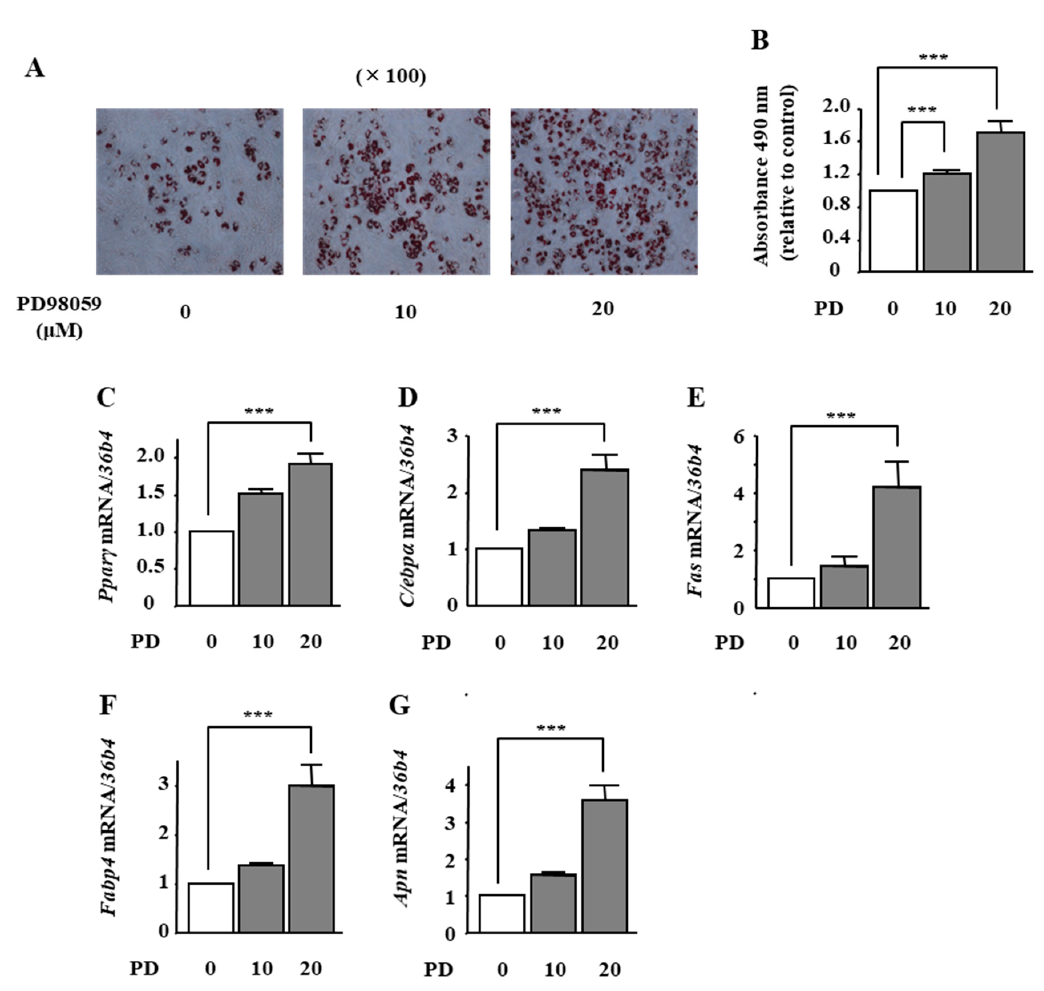
Figure 4. The effects of the MEK inhibitor PD98059 on adipocyte differentiation in ST2 cells. ( A , B ) After reaching confluency, ST2 cells were incubated in adipogenic medium with the MEK inhibitor PD98059 (0, 10, and 20 µM) for 8 days. Thereafter, oil red O staining and its quantification were performed. The results are representative of at least seven different experiments. The quantification results are expressed as mean ± SE ( n = 8); *** p < 0.001. ( C – G ) After reaching confluency, the cells were incubated in adipogenic medium with PD98059 (0, 10, and 20 µM) for 4 days. The mRNA expression of adipogenic differentiation markers ( Ppar γ , C/ebp α , Fas , Fabp4 , and Apn ) was examined by real-time PCR. The results are expressed as mean ± SE ( n = 7); *** p < 0.001. PD: PD98059.